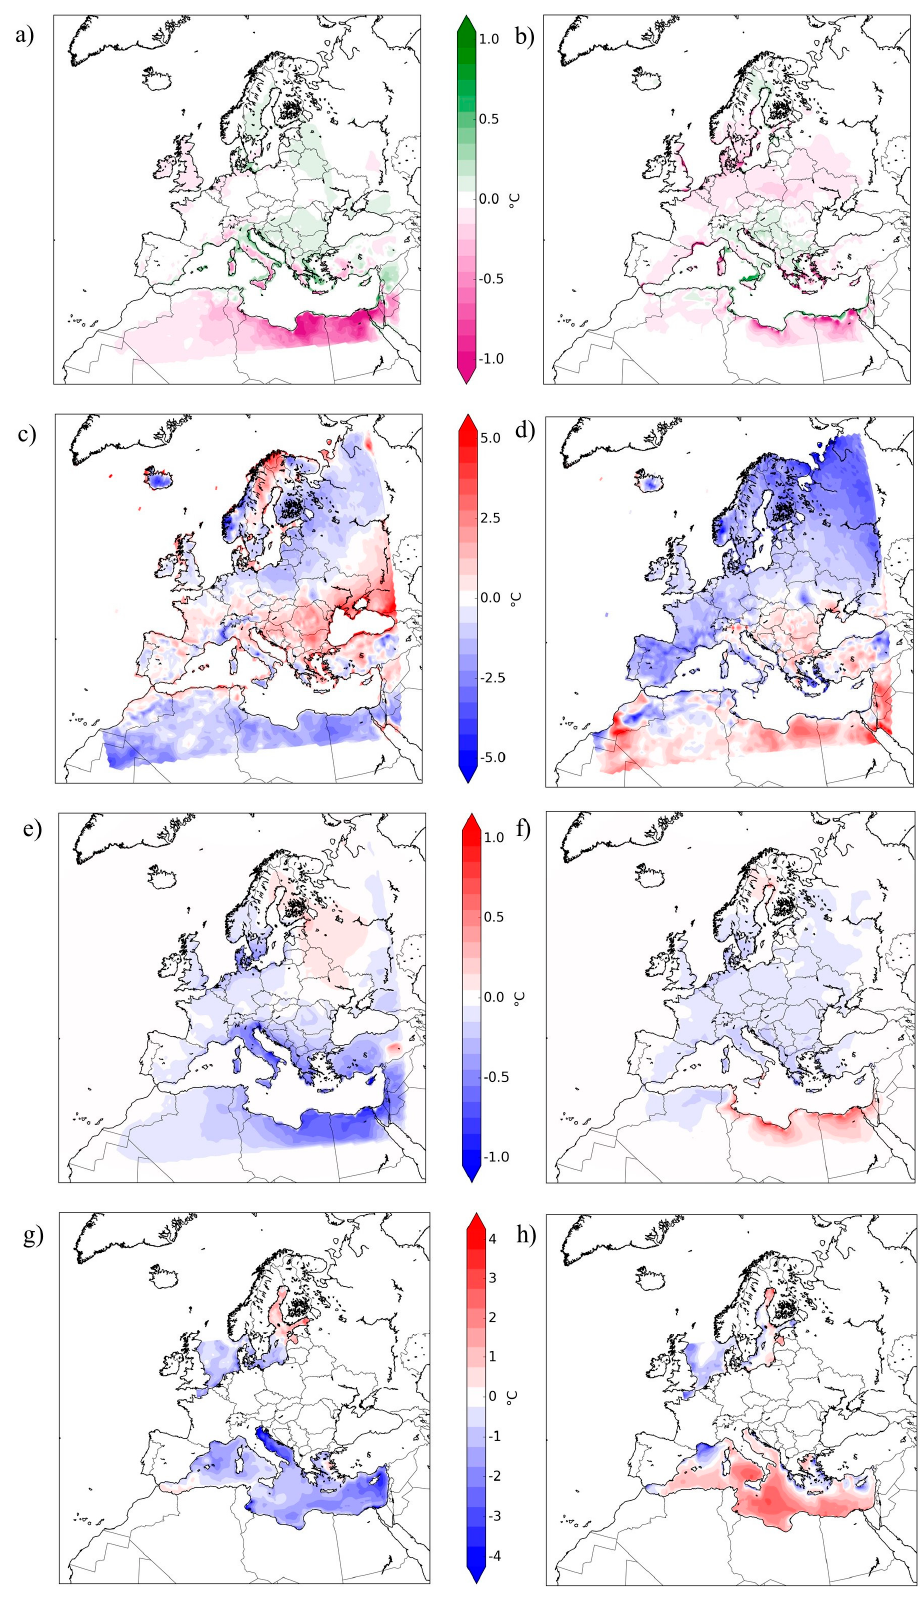
Figure 7. Winter (left column) and summer (right column) mean 2 m air temperature ( a , b ) MSESS ( c , d ) bias compared to CRU data and ( e , f ) difference between coupled and uncoupled simulation. ( g , h ) Seasonal mean SST difference between coupled and uncoupled simulation5. Discussion and Conclusions.